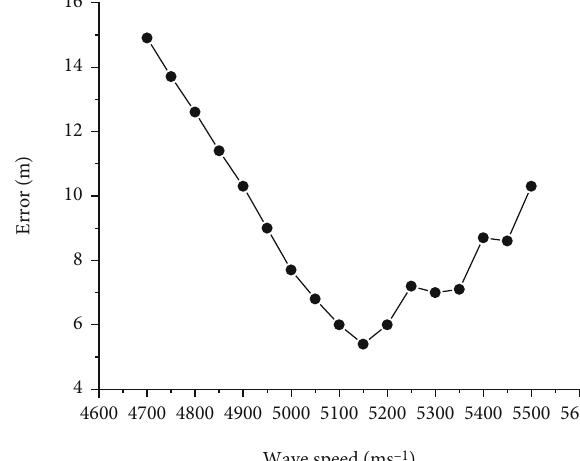
Figure 7: Relation curve between wave velocity and position